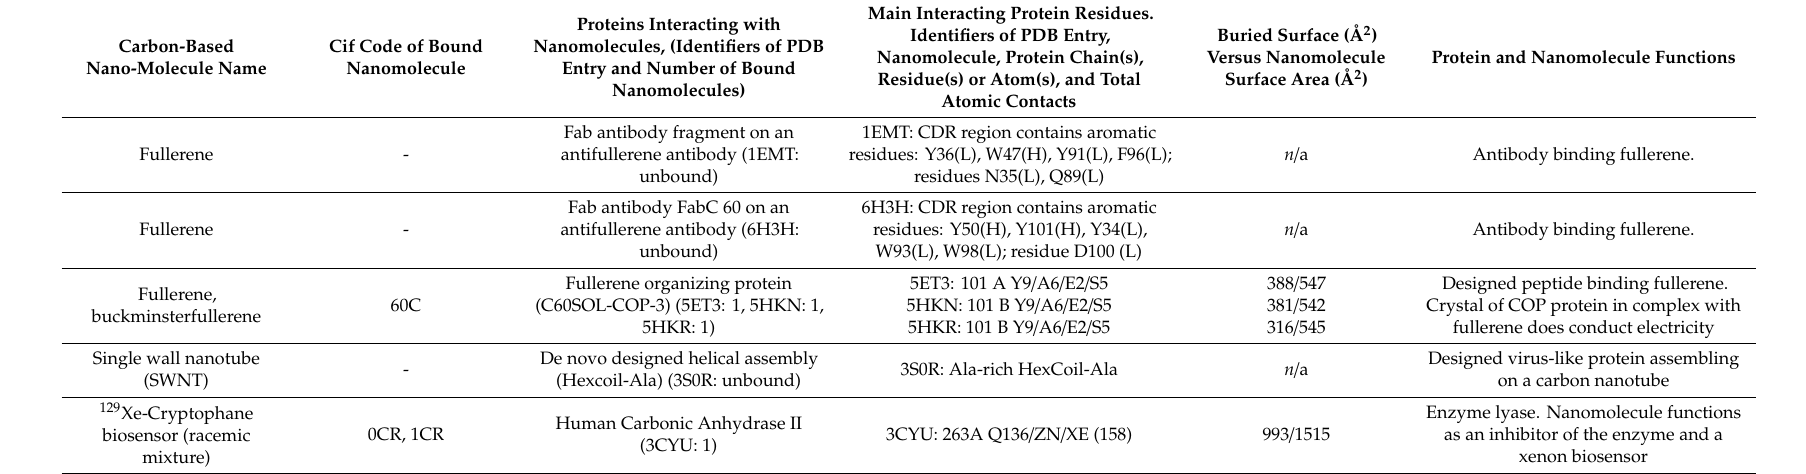
Table 1. Crystal structures of protein binding to nanomolecules or protein-nanomolecule complexes discussed in this review and retrieved from the Protein Data Bank. Nanomolecule buried surface area upon complex formation (Å 2 ), surface areas of individual nanomolecule (uncomplexed, Å 2 ), and protein and / or nanomolecule function are indicated. Ligand chemical structures and other ligand annotations can be retrieved using the indicated nanomolecule cif code from the following link: https: //